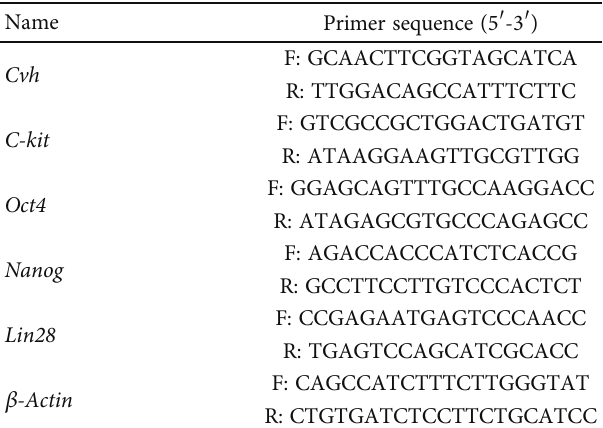
Figure 1: Separation and identi fi cation of ESCs and PGCs. (a) Diagram of ESCs developing into PGCs. (b) Cell morphology of chicken ESCs and PGCs. Scale bars = 200 μ m. (c, d) Detection of pluripotent genes and PGCs speci fi c genes expression by qRT-PCR in ESCs and PGCs. ∗ p < 0 : 05 , ∗∗ p < 0 : 01 . (e) PGCs were stained against CVH with a rabbit monoclonal antibody. Table 1: Primer sequence of the